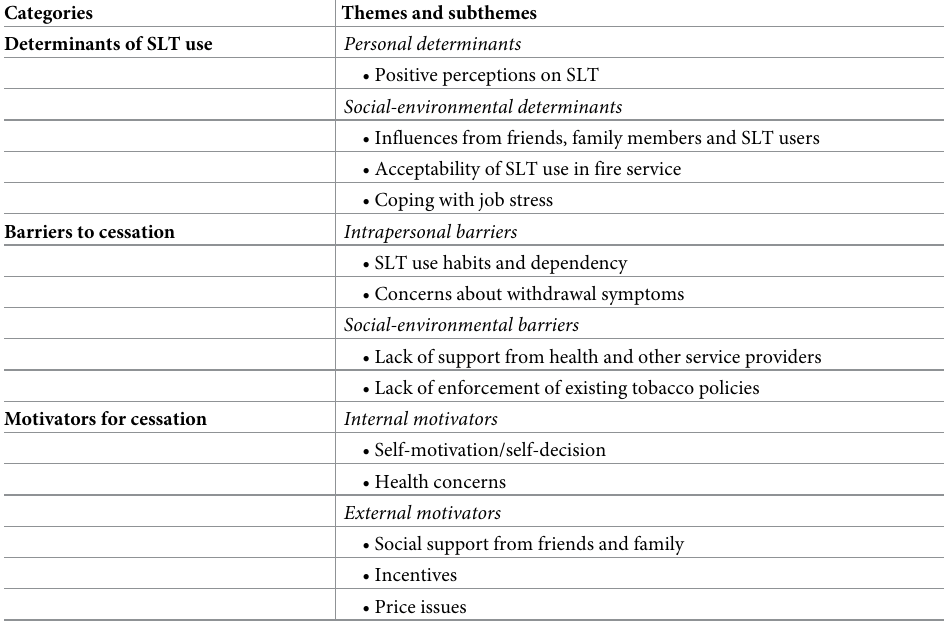
Table 2. Determinants of SLT use, barriers to cessation, and motivators for SLT cessation among participants. Categories